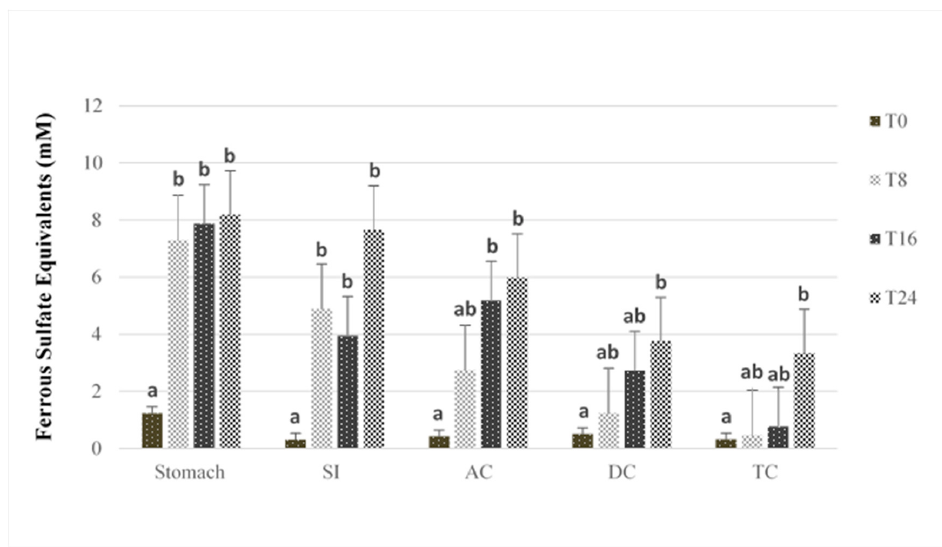
Figure 2. FRAP antioxidant capacity after human stimulated intestinal digestion at baseline (T0) and after 8 h (T8), 16 h (T16) and 24 h (T24) of digestion. SI = small intestine; AC = ascending colon; TC = transverse colon; DC = descending colon. Data are represented as means ± SE. Bars that do not share the same letter within the same vessel are significantly ( p < 0.05) different from each other, based on Tukey’s honest significant difference (HSD) posthoc test.